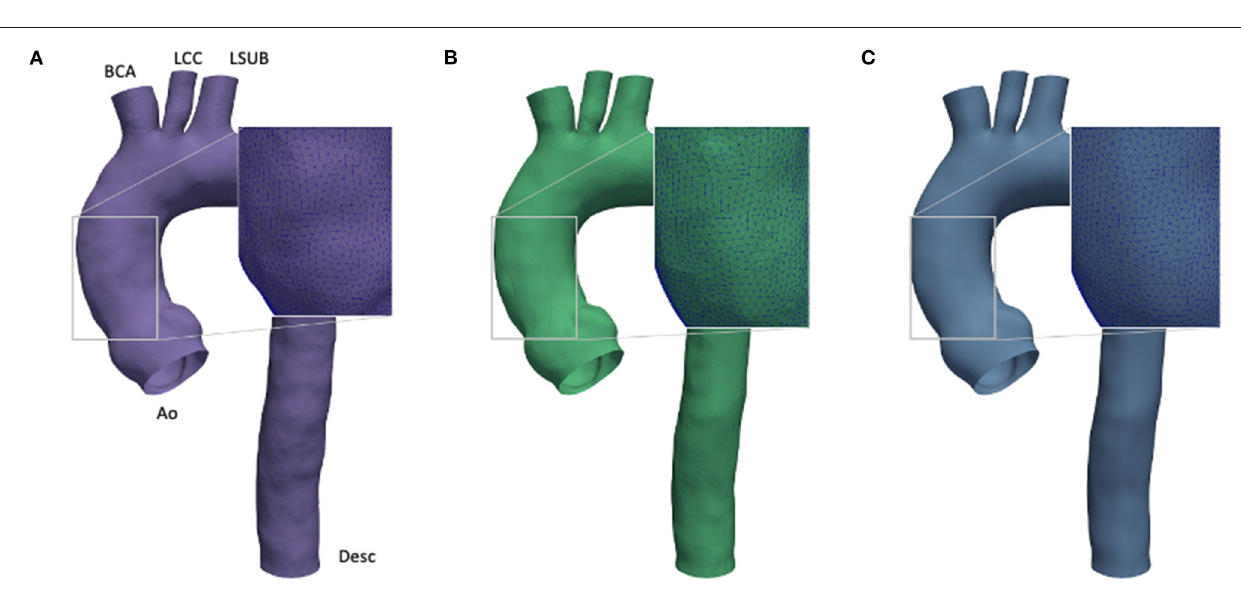
FIGURE 2 | Comparison of effect of different smoothing levels. Segmented aortic geometry at phase p 0 with smoothing: low ( S L ) (A) , medium ( S M ) (B) , and high ( S H ) (C)